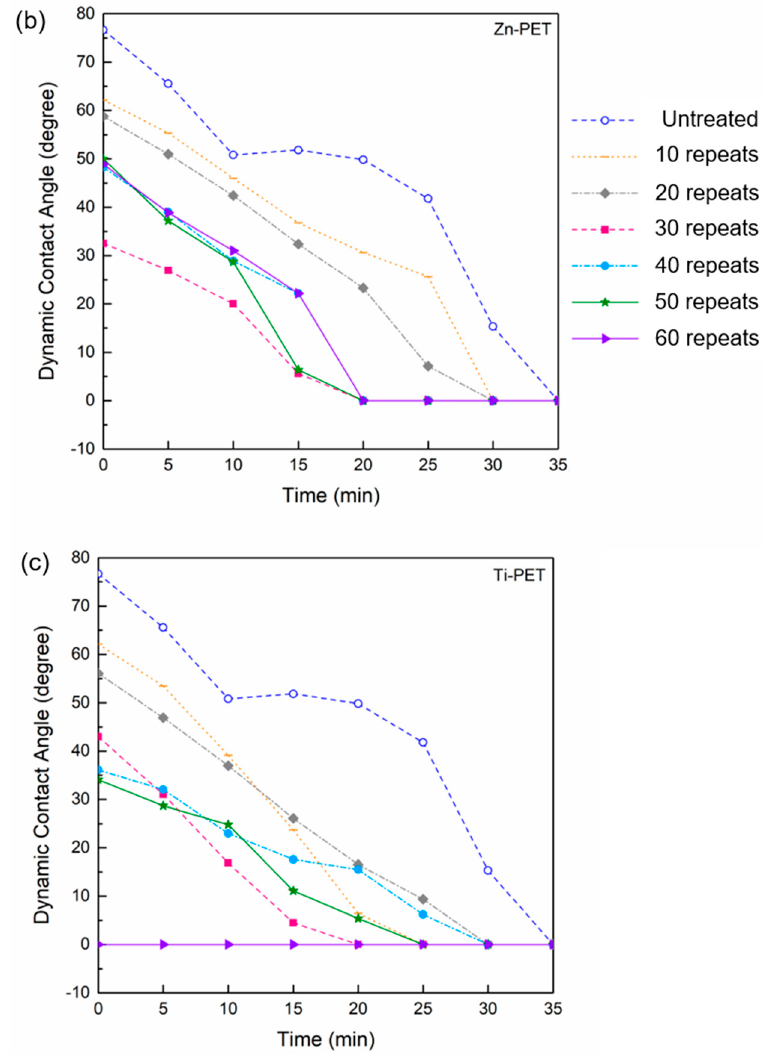
Figure 6. Dynamic contact angle curves of the ( a ) Ag-PET, ( b ) Zn-PET, and ( c ) Ti-PET films treated 0–60 times.